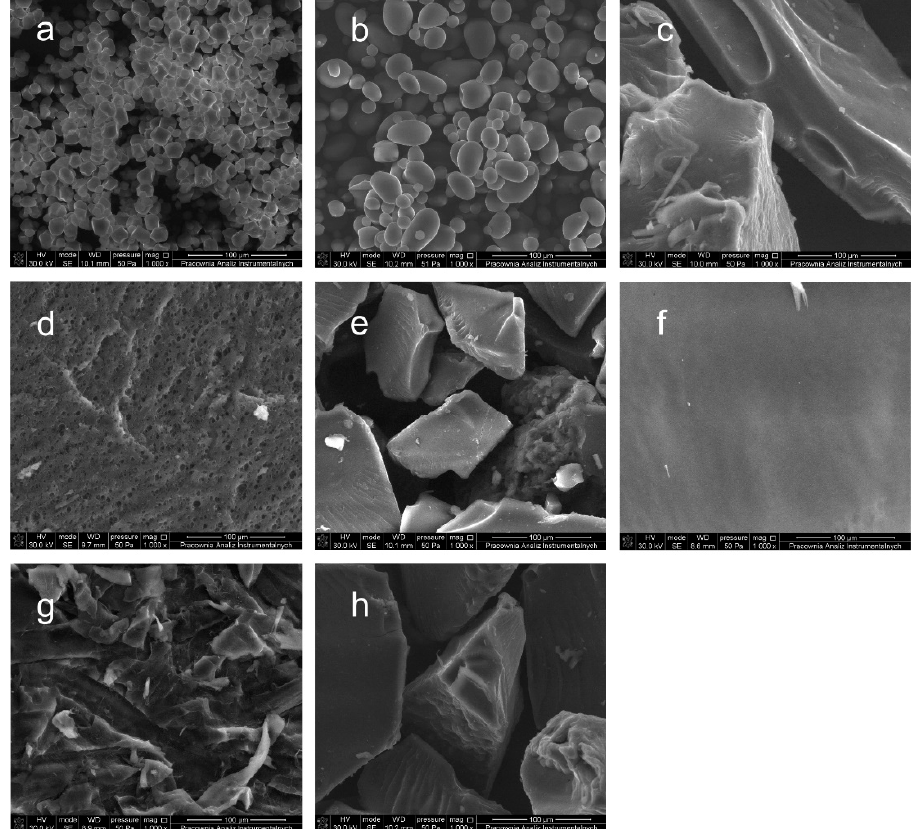
Figure 4. SEM images at 1000x magnification of substances: ( a ) corn starch, ( b ) solvent starch, ( c ) CS- g-PAA (CAN/U/NaOH), ( d ) CS-g-PAA (KPS/U/NaOH), ( e ) SS-g-PAA (CAN), ( f ) SS(12)-g-PAA ( c ) CS-g-PAA (CAN / U / NaOH), ( d ) CS-g-PAA (KPS / U / NaOH), ( e ) SS-g-PAA (CAN), ( f ) SS(12)-g-PAA (CAN), ( g ) SS-g-PAA (12/CAN), ( h ) SS-g-PAA (KPS). (CAN), ( g ) SS-g-PAA (12 / CAN), ( h ) SS-g-PAA